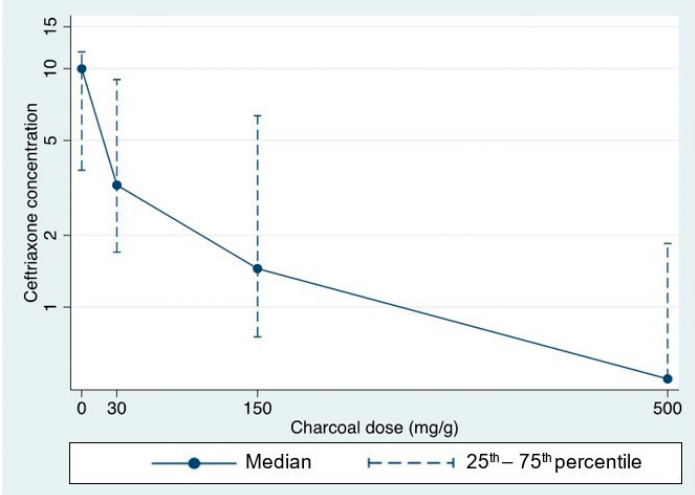
Figure 5. Graph showing decreasing median (IQR) ceftriaxone concentrations (mcg/mL) with increasing activated charcoal doses added; dataset 1 (N = 8, all X 1–8 ). Note: y -axis is on a logarithmic scale.